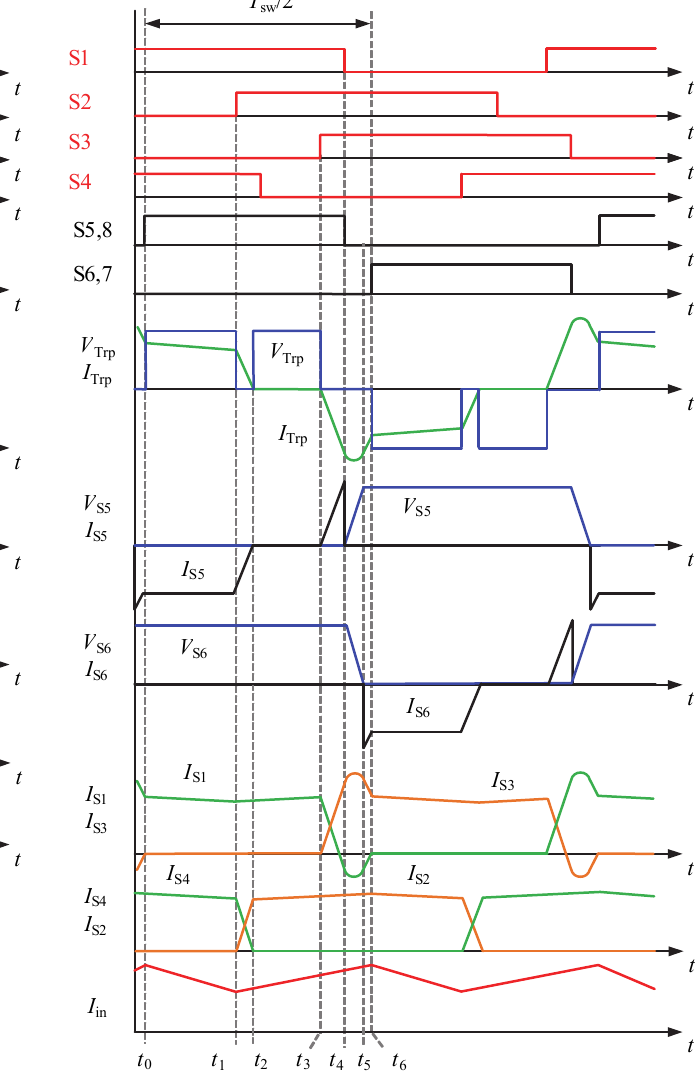
Fig. 3. Idealized operating waveforms of ASMC with an active